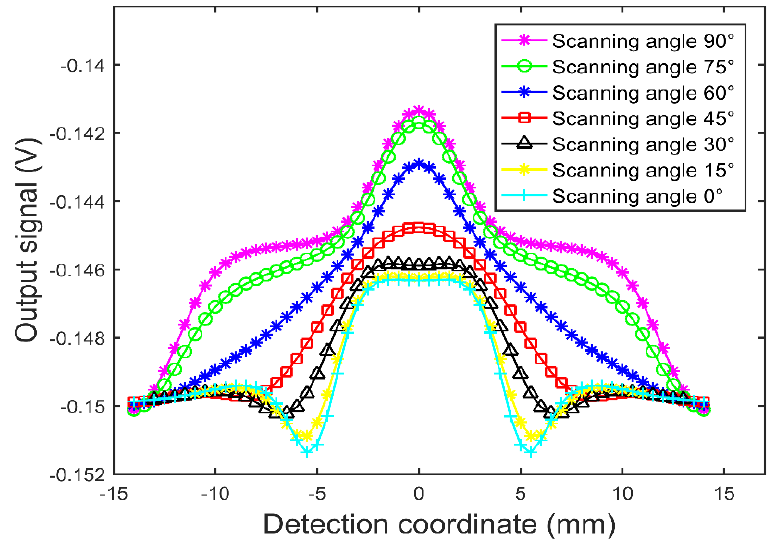
Figure 11. The simulated crack defect signals of the dual-excitation UEC probe at different scan- ning angles.